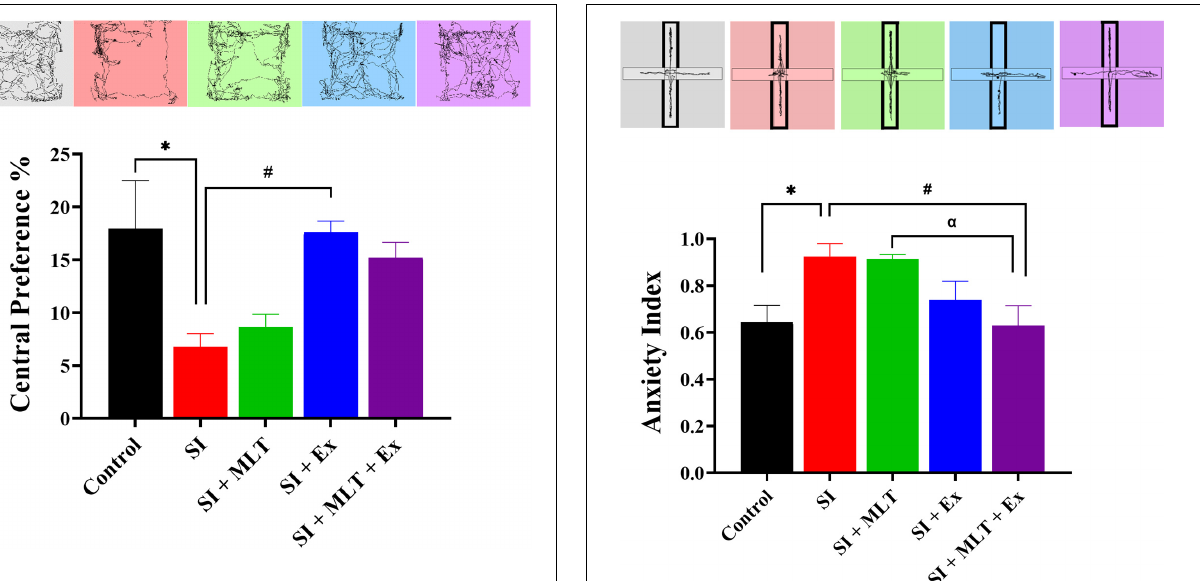
FIGURE 4 | The effect of MLT and Ex on the central preference percentage among groups in the open field test. Data are presented as the mean ± SEM. One-way ANOVA was used, followed by Tukey’s multiple comparisons test. ∗ indicates a significant difference between the treated groups and the control group at p > 0.05; # indicates a significant difference between the treated groups and the SI group at p > 0.05.